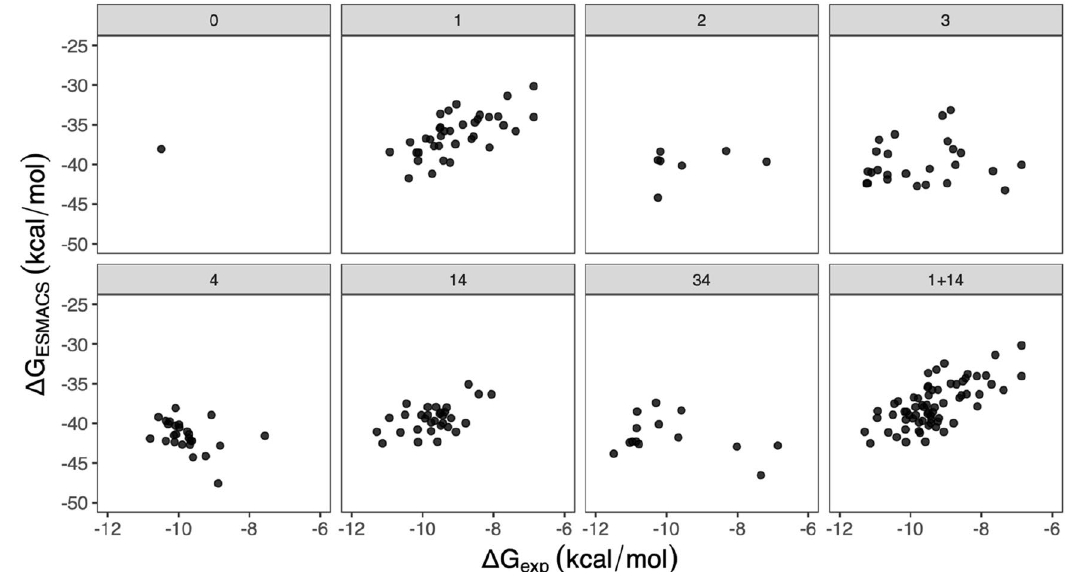
Figure 4. Free energy differences from ESMACS for the electrostatically neutral compounds, grouped into subsets of clusters. In each subset structural modification to L30 (denoted as 0) is restricted to specific regions, with increasing numbers of regions being included. The sets are: (1) ether variations, (2) pyridyl variation, (3) central aryl variation, (4) lactam substituent variation. The numbers (1–4) and their combinations also refer to the different data sets displayed in the panels.